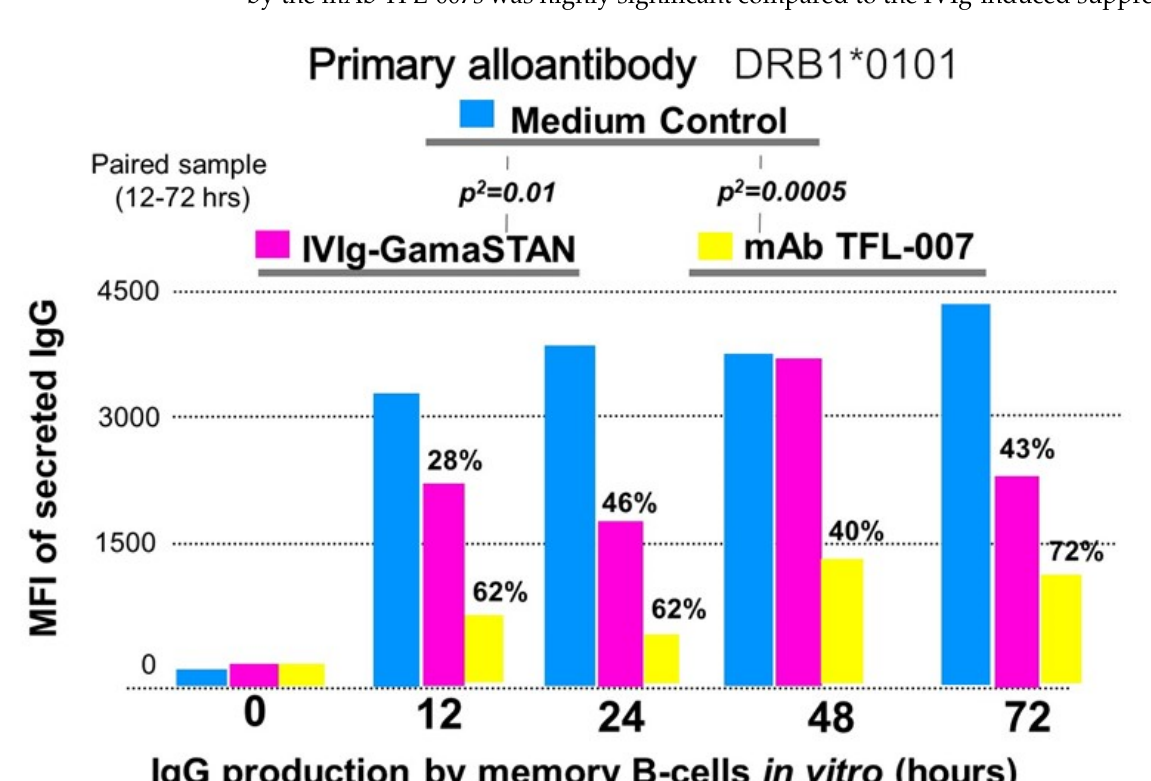
Figure 10. The impact of IVIg (GamaSTAN) and HLA-I polyreactive mAb (TFL-007) on the primary alloantibody DRB1*0101 (IgG), secreted by activated B-lymphocytes obtained from an alloimmunized woman. GamaSTAN S/D IVIg was used at 1:100 dilution, 1.5 mg. protein/mL. At the time when the IVIg was added, the cytokine combo and anti-CD40 antibody were not added. In all panels, the mean fluorescent intensity (MFI) of alloantibody secretion is compared between the medium control and treatment with IVIg and HLA-I polyreactive IgG2a mAb TFL-007. IVIg inhibited the secretion of the primary alloantibody at a significant level ( p 2 = 0·01). HLA-I polyreactive mAb inhibited the secretion of the primary alloantibody at a higher significant level ( p 2 = 0.0005). This is an original figure .